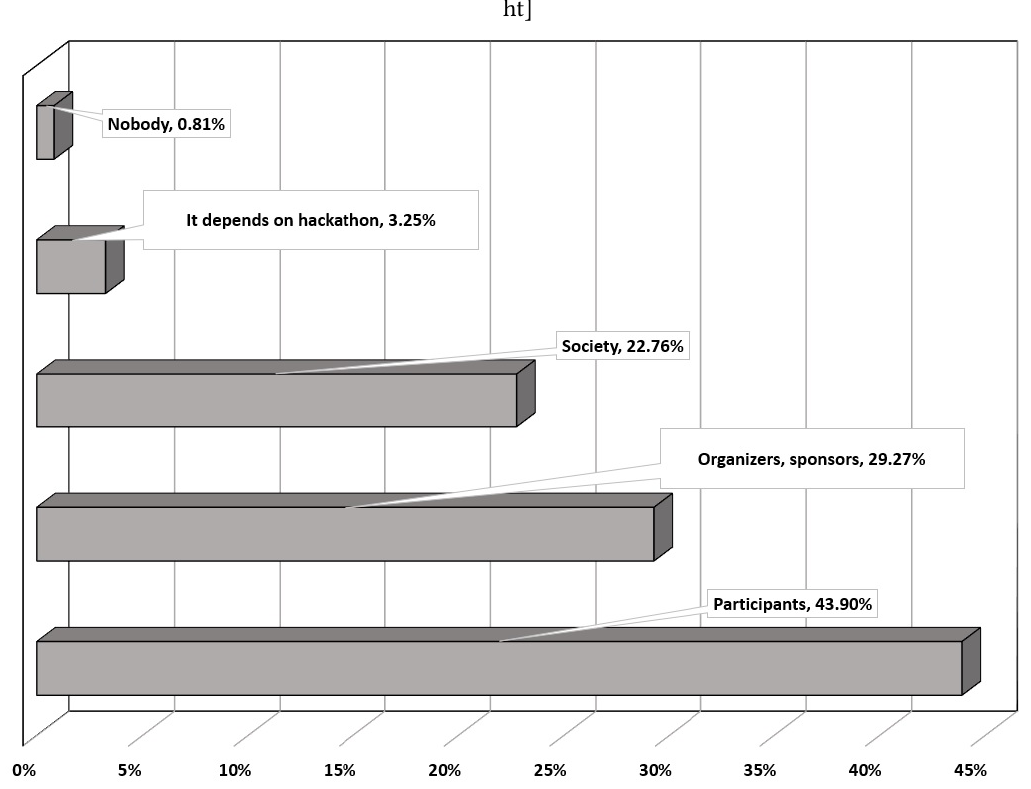
Figure 2: Answers to the question “Who are the main beneficiaries of